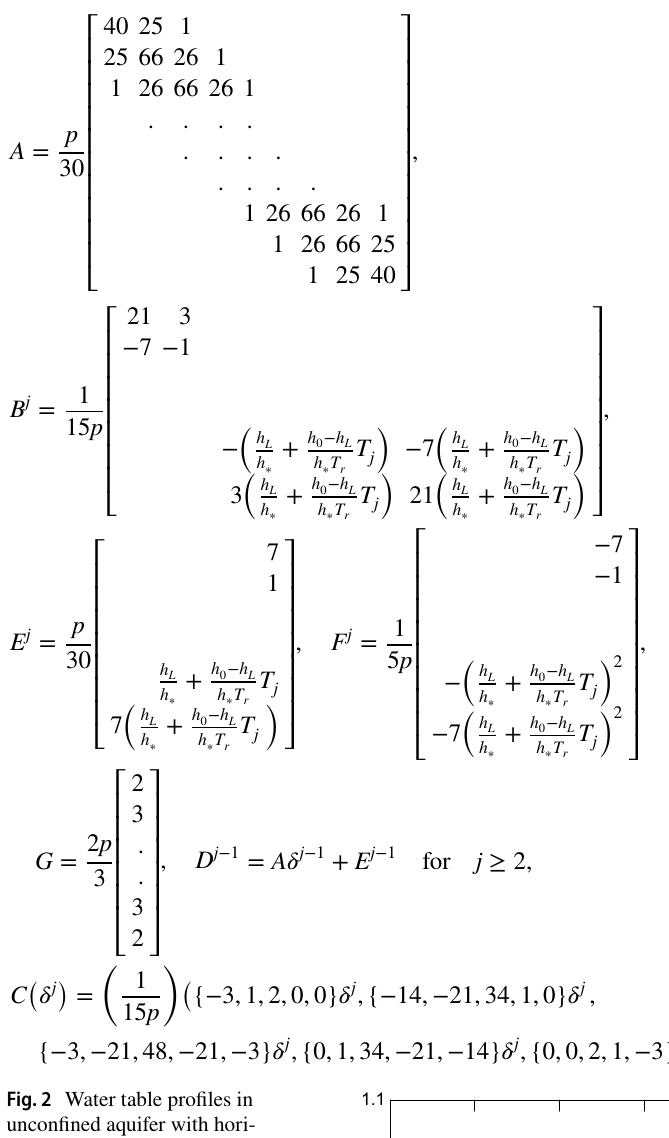
unconfined aquifer with hori- zontal impermeable bed with